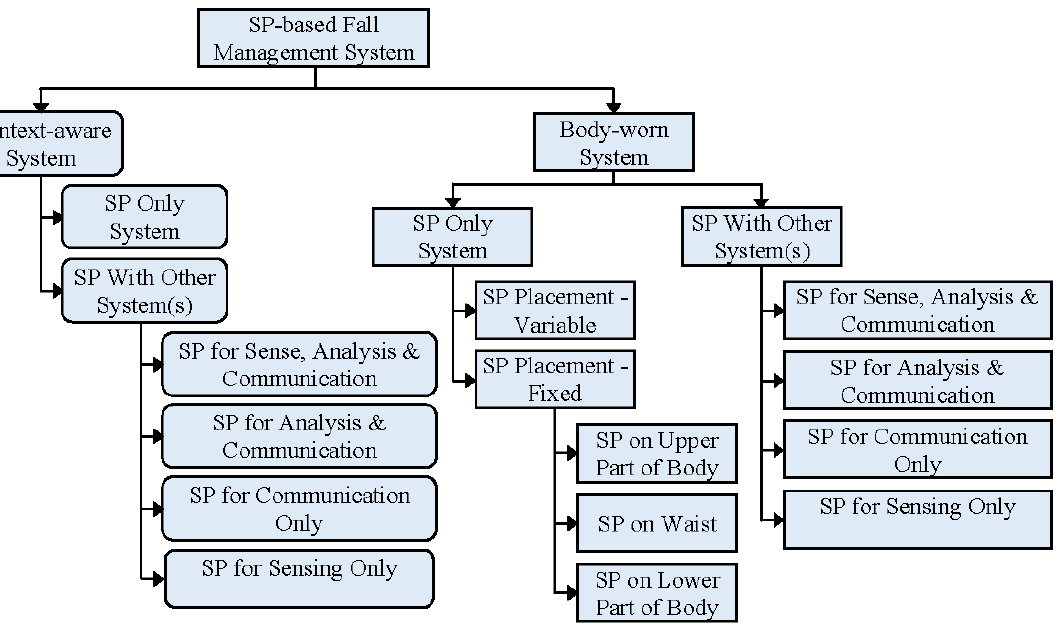
Figure 2. Taxonomy of smartphone-based systems based on sensing mechanism and sensor placement.